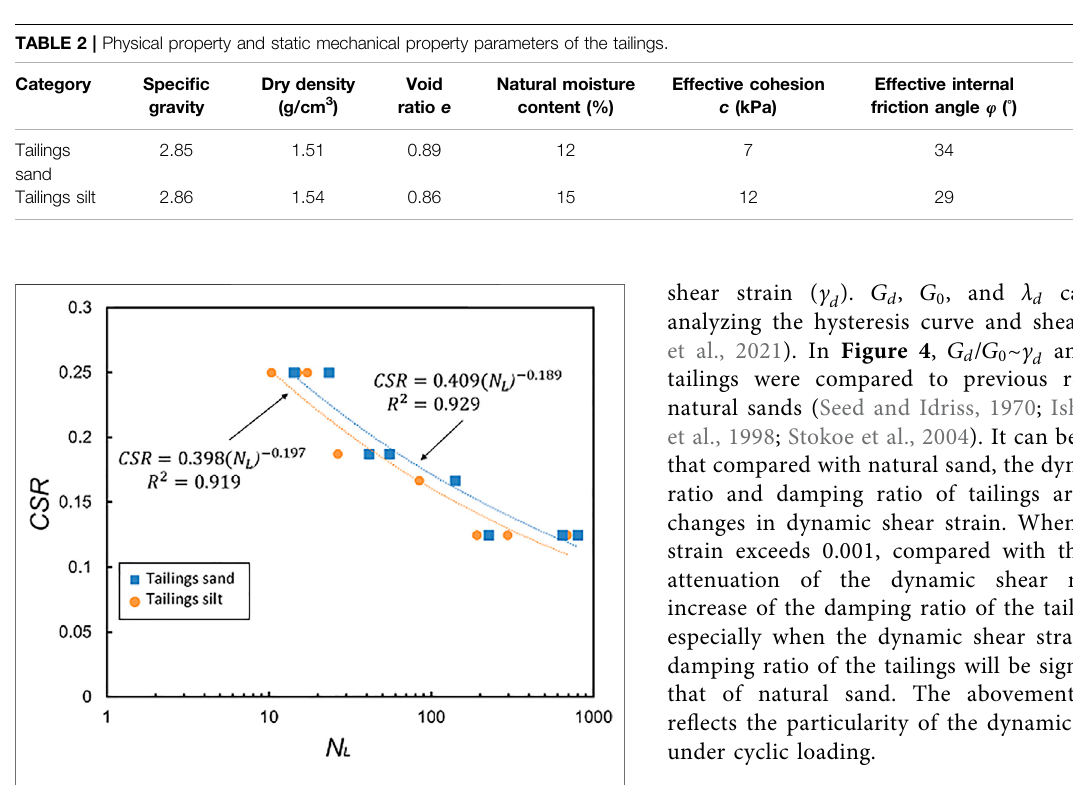
FIGURE 3 | Number of liquefaction failure cycles ( N L ) versus the cyclic shear stress ratio ( CSR ) of the tailings.